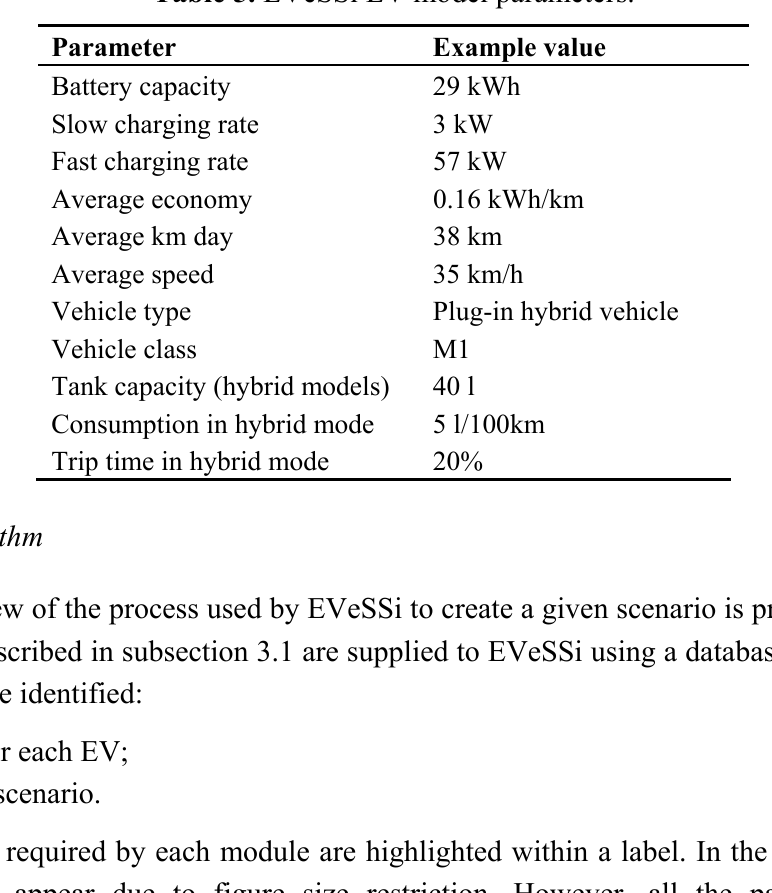
Table 5. EVeSSi EV model